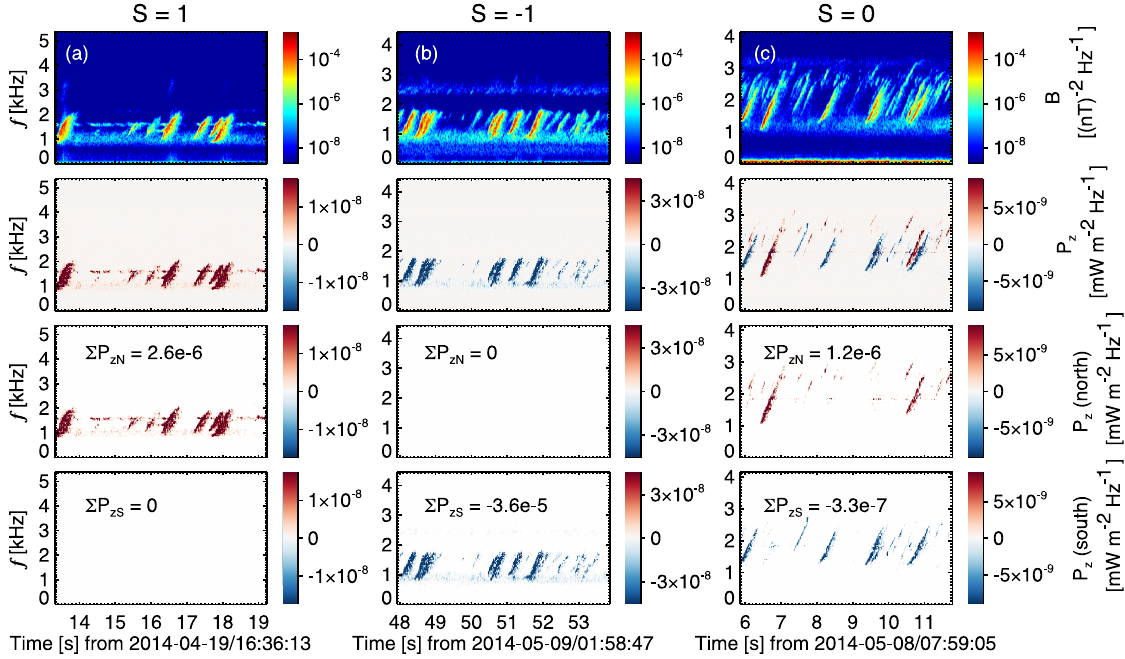
Figure 4. Illustration of three types of S : S = 1 (a) , − 1 (b) , and 0 (c) . From top to bottom rows: the magnetic power spectra density, the z component of the Poynting flux vector ( P z ), and the northward and southward P P z .